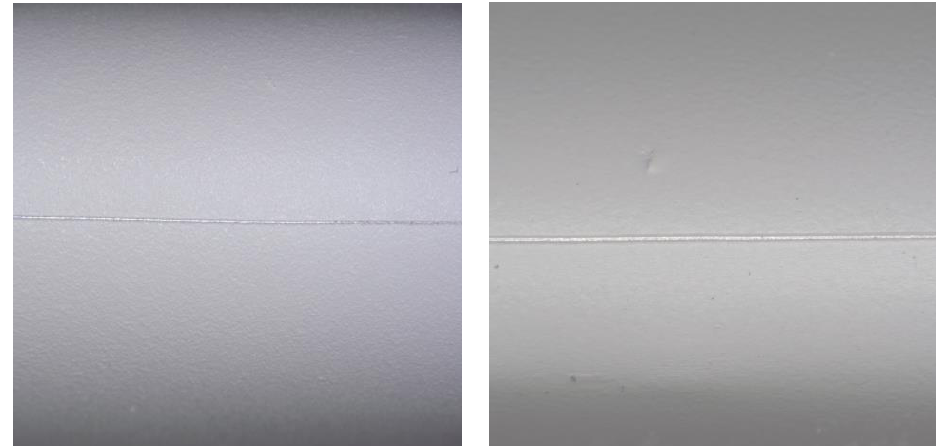
Figure 14. Results of a successful bending test.